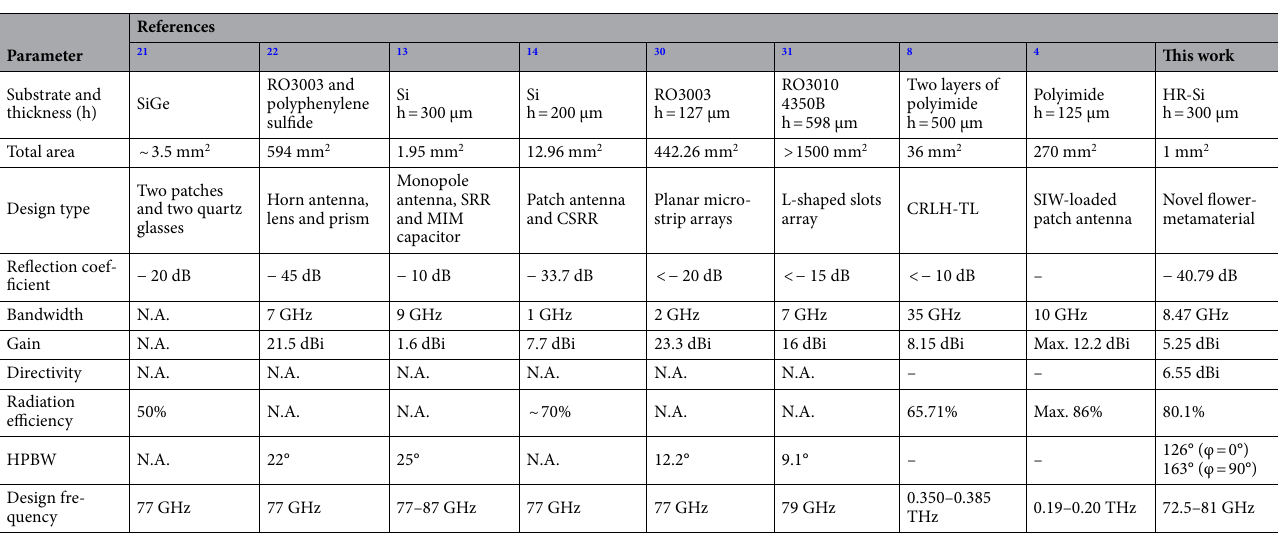
Table 2. Comparison with related works. N.A. not available, SRR split ring resonator, CSRR composite split ring resonator, CRLH-TL composite right-left handed transmission line, SIW substrate integrated